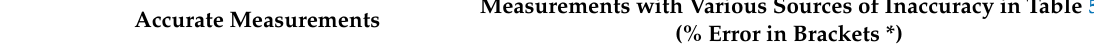
Table 3. Average axle force for different levels of damage.